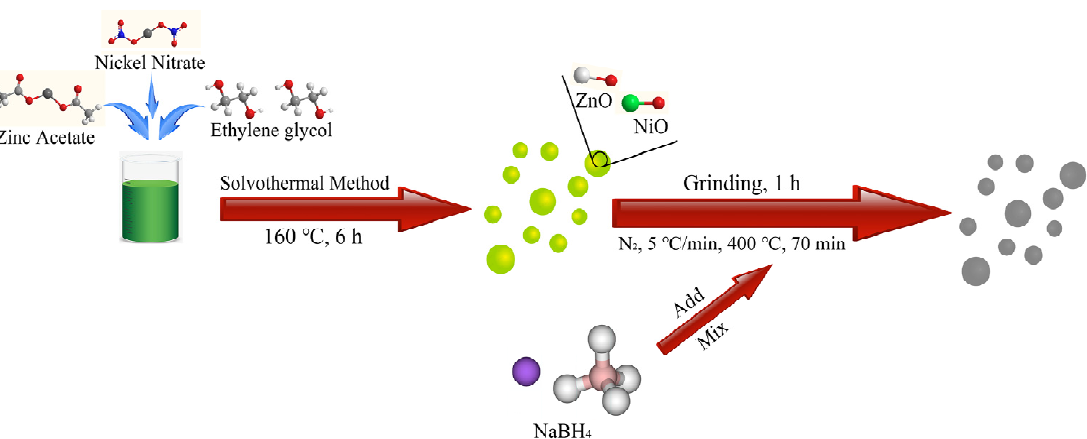
Figure 1. Schematic synthesis of ZnO/NiO nanoparticles with stable oxygen vacancy structures.